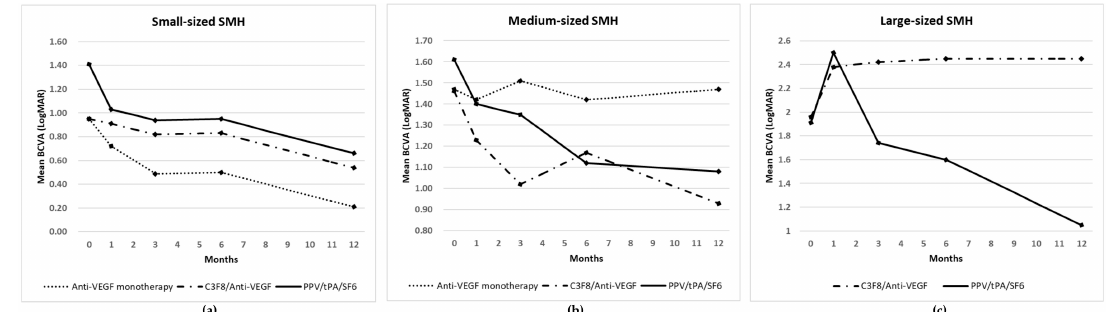
Figure 1. Changes in the mean best-corrected visual acuity (BCVA) in the ( a ) small-, ( b ) medium- and ( c ) large-sized submacular hemorrhage (SMH) groups. The eyes were treated with anti-vascular endothelial growth factor (anti-VEGF) monotherapy, pneumatic displacement (PD) using perfluoropropane (C 3 F 8 ) with an anti-VEGF injection or a pars plana vitrectomy (PPV) with a subretinal tissue plasminogen activator (tPA) and gas tamponade using sulfahexafluoride (SF 6 ). C 3 F 8 /Anti-VEGF, PD with anti-VEGF; LogMAR, logarithm of the minimal angle of resolution; PPV/tPA/SF 6 , PPV with subretinal tPA and gas tamponade.